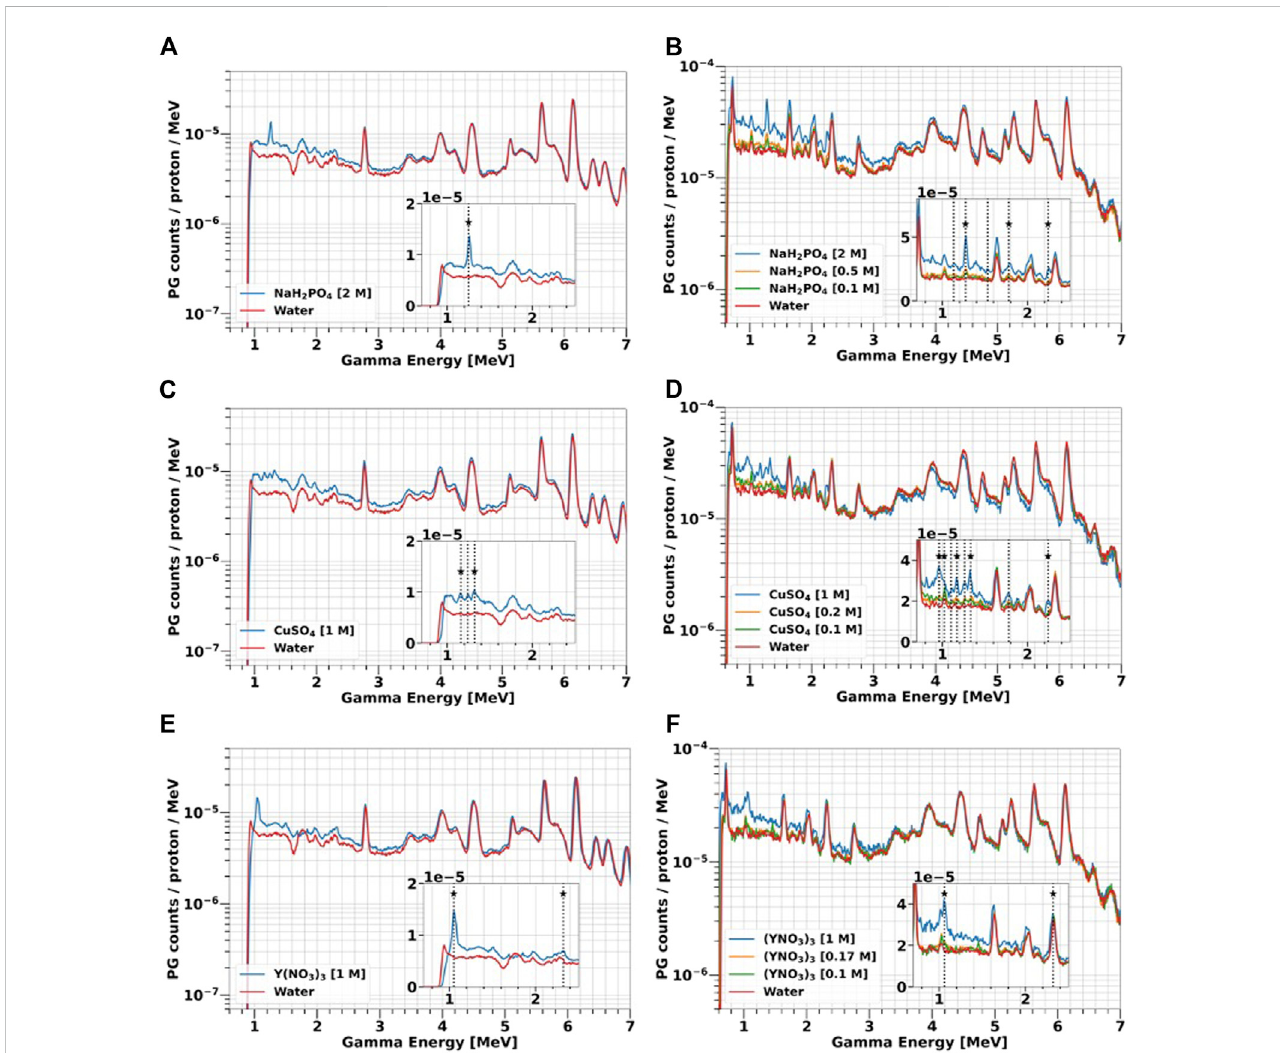
FIGURE 8 PGsemittedbywater-basedsolutionsof 31 P (A,B) , 63 Cu (C,D) and 89 Y (E,F) atdifferentconcentrations(0.1 – 2 M)andexposedto25and70 MeVprotons. The details of the experiments can be found in Section 2.2. The spectra acquired with water are plotted as a representation of the tissues background. The boxes contain a zoom of the spectra in the low-energy range. The vertical lines indicate all the PG peaks experimentally detected, while the stars mark those predicted by TALYS (Table